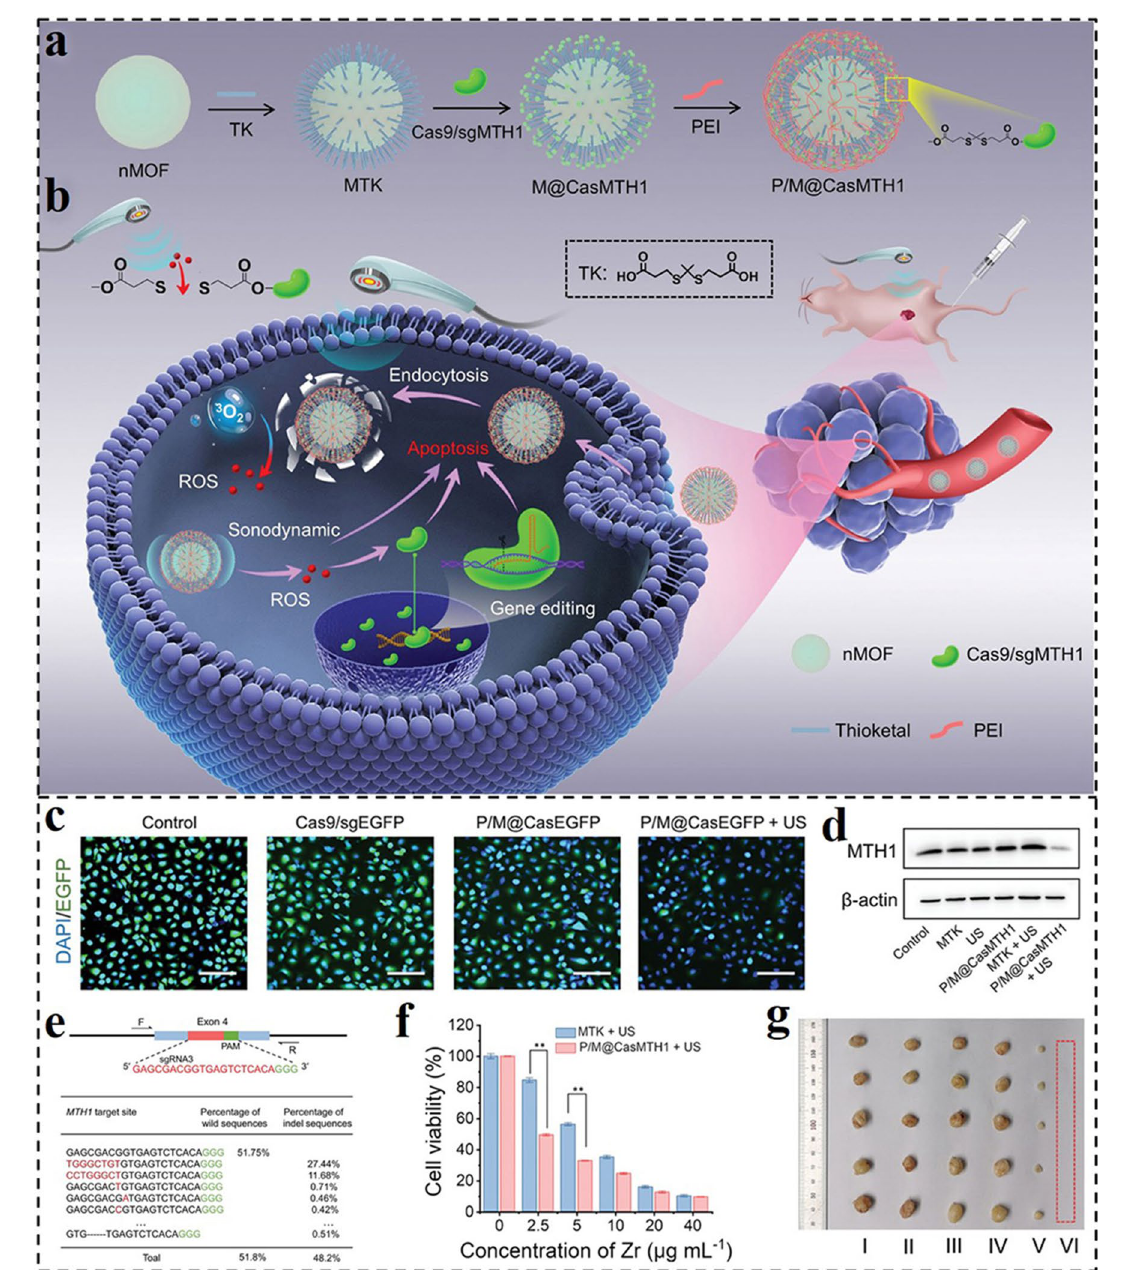
Fig. 16 Schematic illustration of a fabrication of the nanosonosensitizer P/M@CasMTH1 and b US-triggered genome-editing-augmented SDT for tumor treatment. c Confocal laser scanning microscopy (CLSM) images of A549-EGFP cells after different treatments. d Western blot analysis of the MTH1 expression in A549 cells after different treatments. e NGS analysis of indel percentage in P/M@CasMTH1 or P/M@ CasMTH1 + US treatment groups. f Viability of A549 cells after SDT or combined therapy treatment. g Digital photographs of dissected tumors in different treatment groups [181]. Copyright 2021, Wiley–VCH